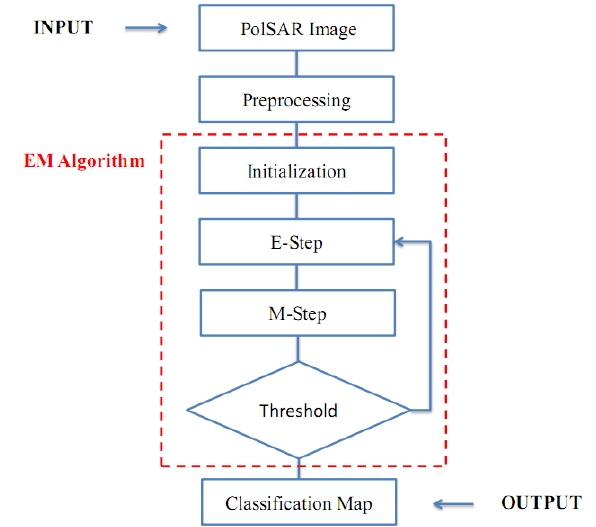
Figure 1. Overall flowchart for proposed unsupervised contextual classification algorithm.